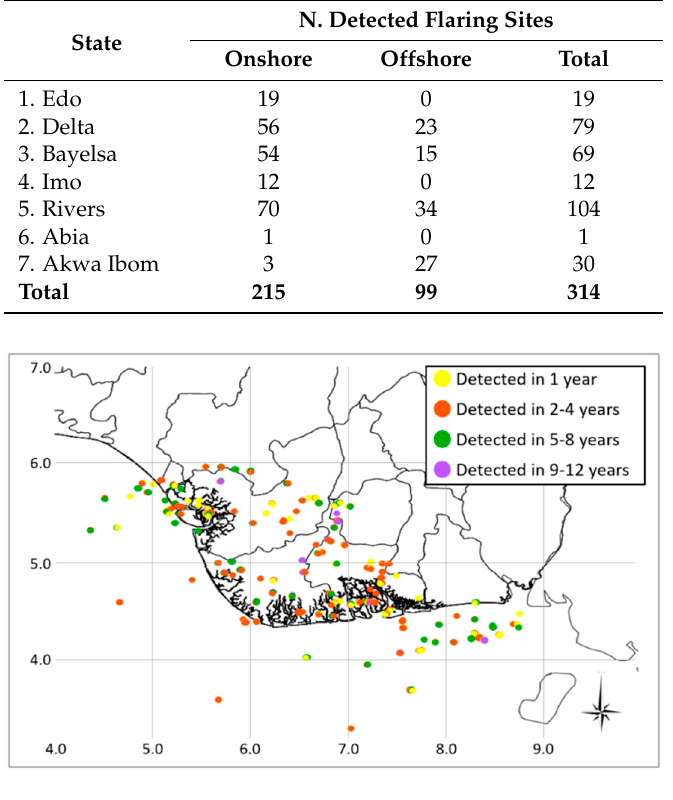
Figure 6. Spatial distribution of flaring sites detected by RST-FLARE in the years 2000–2016, differently colored according to their occurrence frequency.